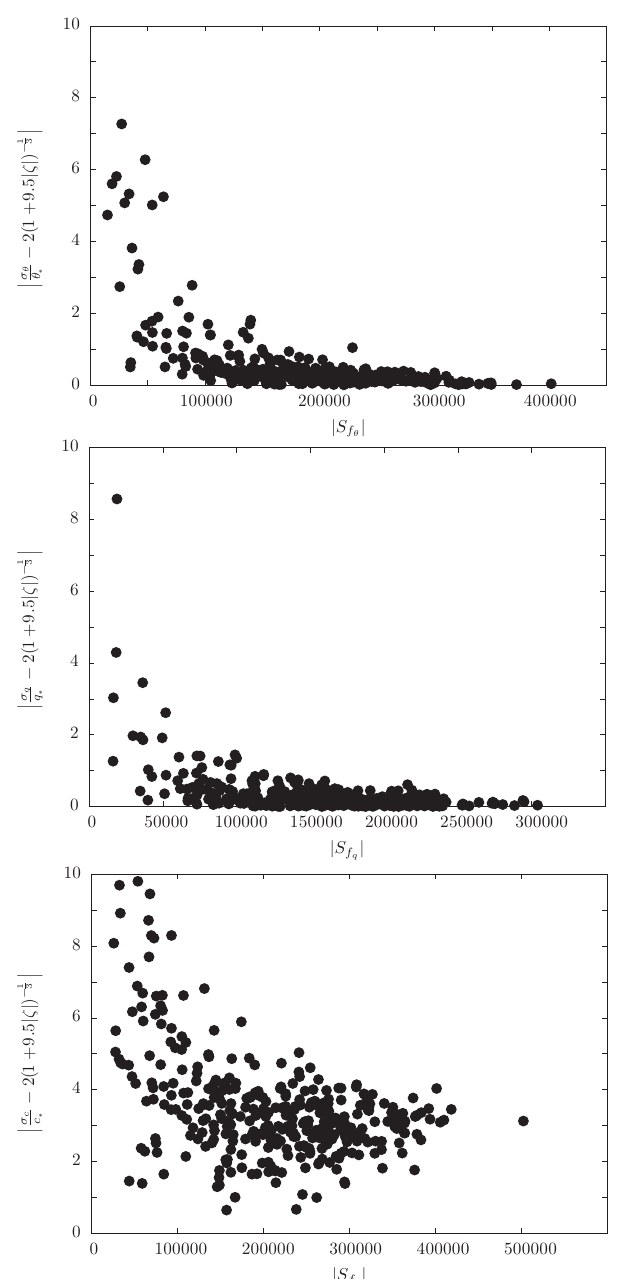
Figure 11. From top to bottom, the departure of the dimensionless standard deviation function, φ a (ζ) , from its surface-layer behavior for θ v , q , and c ,